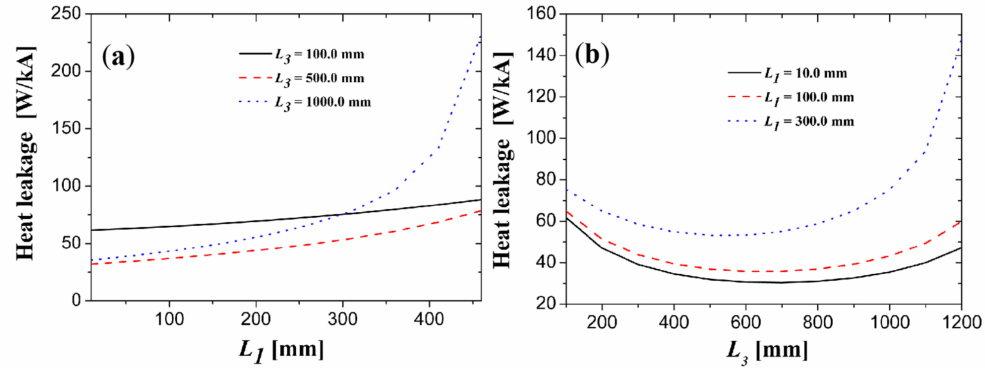
Figure 5. The coupling influence between B ( L 1 ) and C ( L 3 ) on the cold end heat leakage of PCLs. ( a ) The heat leakage vary with B ( L 1 ); ( b )The heat leakage vary with C ( L 3 ). Finally, we optimize the parameter A (radius of the copper leads r 1 ), keeping the other parameters unchanged ( L 1 = 10.0 mm, L 3 = 700.0 mm, r 2 = 10.0 mm, L 2 = 1.0 mm). Figure 6 illustrates the effect of r 1 on the heat leakage of PCLs. Here, we obtain the best value for r 1 = 3 mm and achieve an optimized structure of PCLs with the lowest heat leakage of 30.1 W/kA.